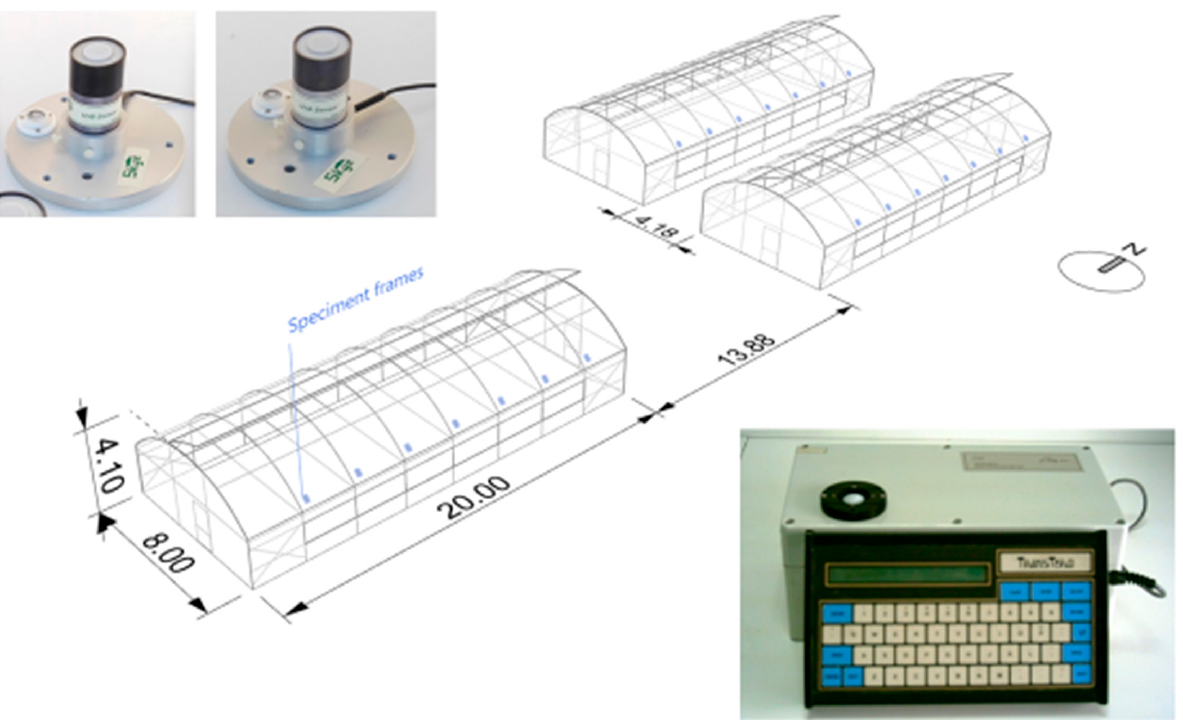
Figure 1. Layout and orientation of the experimental greenhouses. Specimen frames indicate places on the greenhouse roofs where samples of the material were cut off and their transmittance was evaluated. In situ measurements were performed with ultraviolet (UV)-B and UV-A radiation sensors (on the top-left ), while a LI-COR-1800 instrument ( bottom-right ) was used in the laboratory measurements.